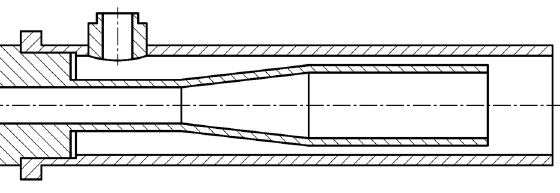
Figure 14. Nozzle structure [56].